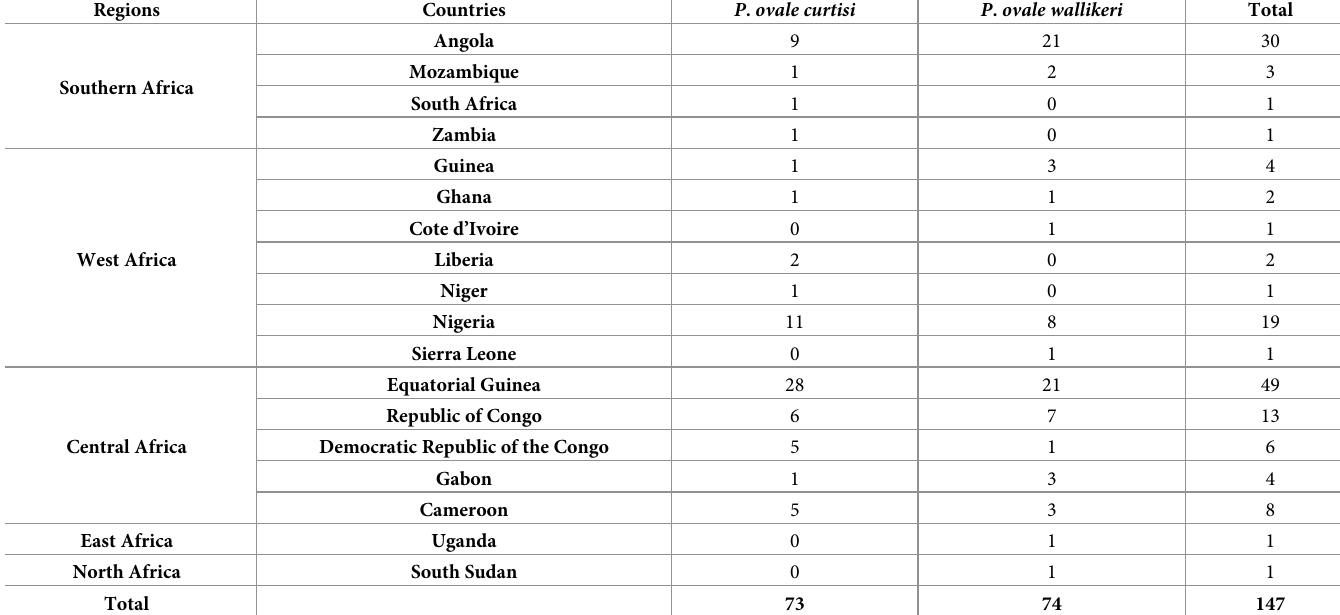
Table 1. Geographic origins of P . ovale spp . samples. Regions